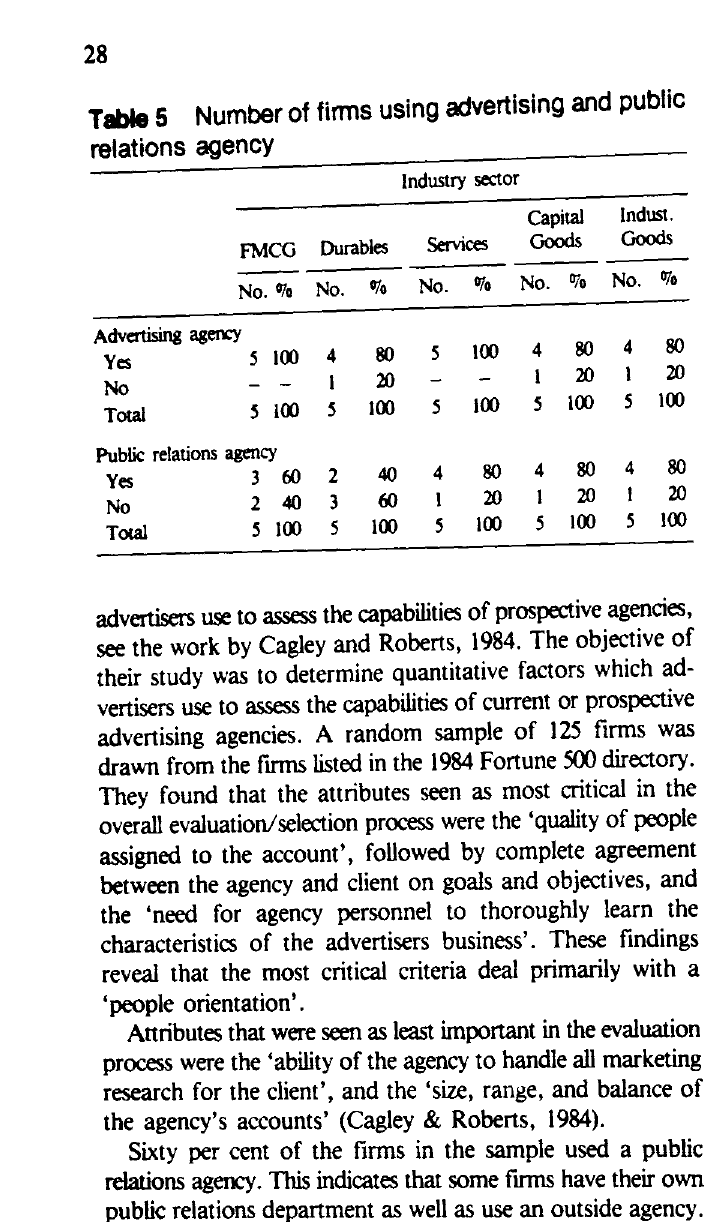
Advertising media